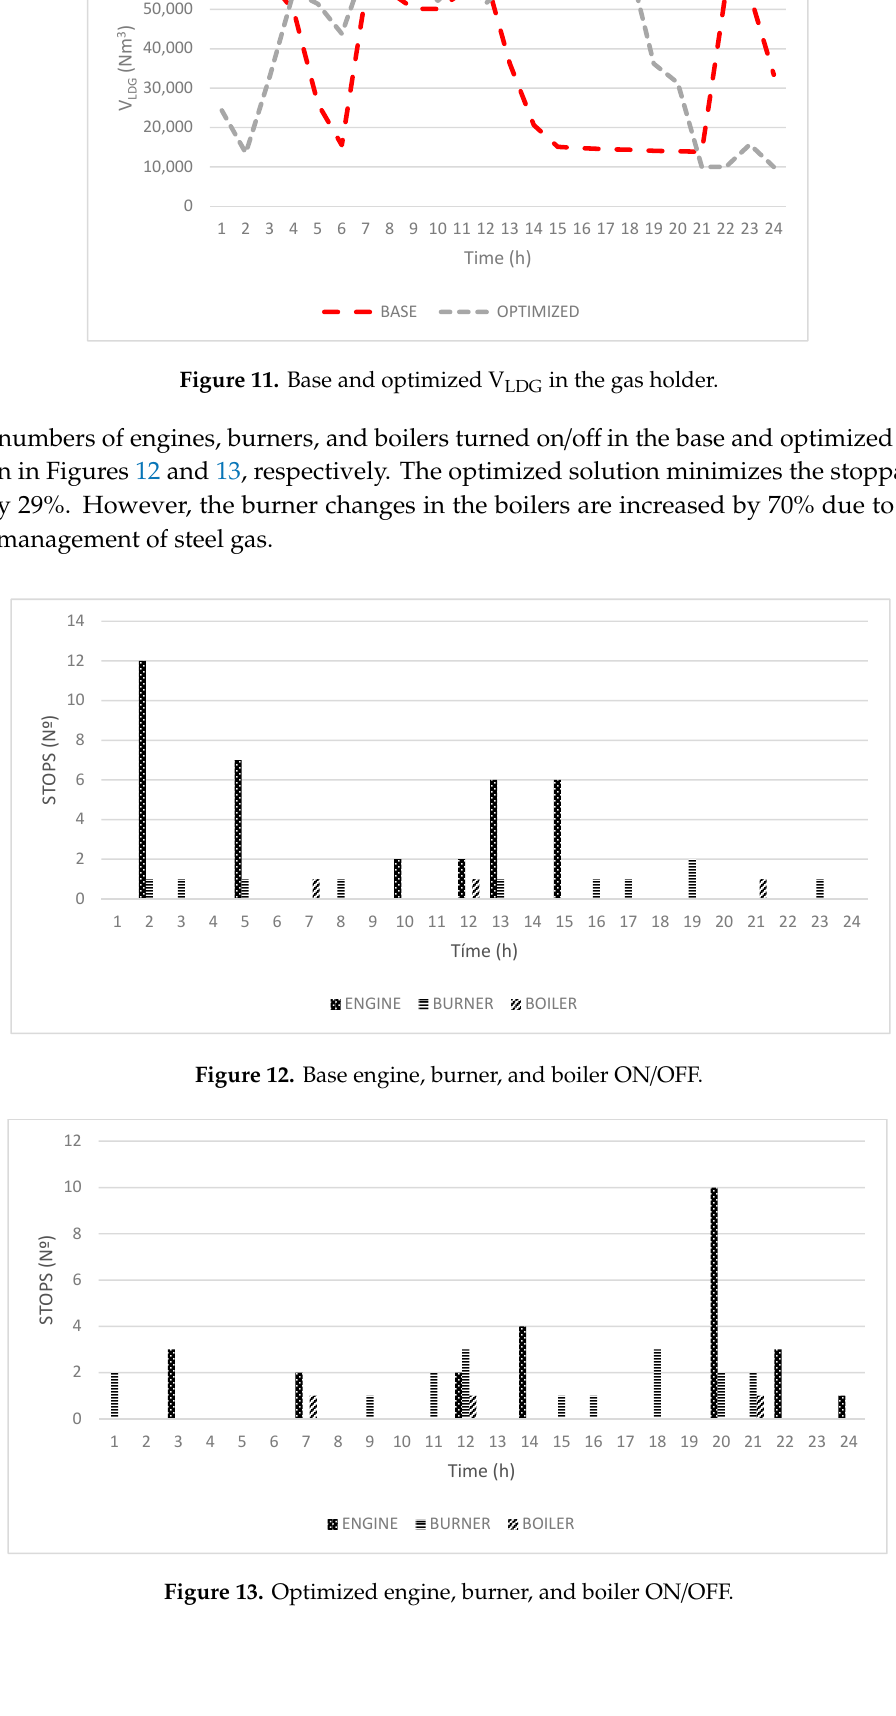
Figure 13. Optimized engine, burner, and boiler ON/OFF.